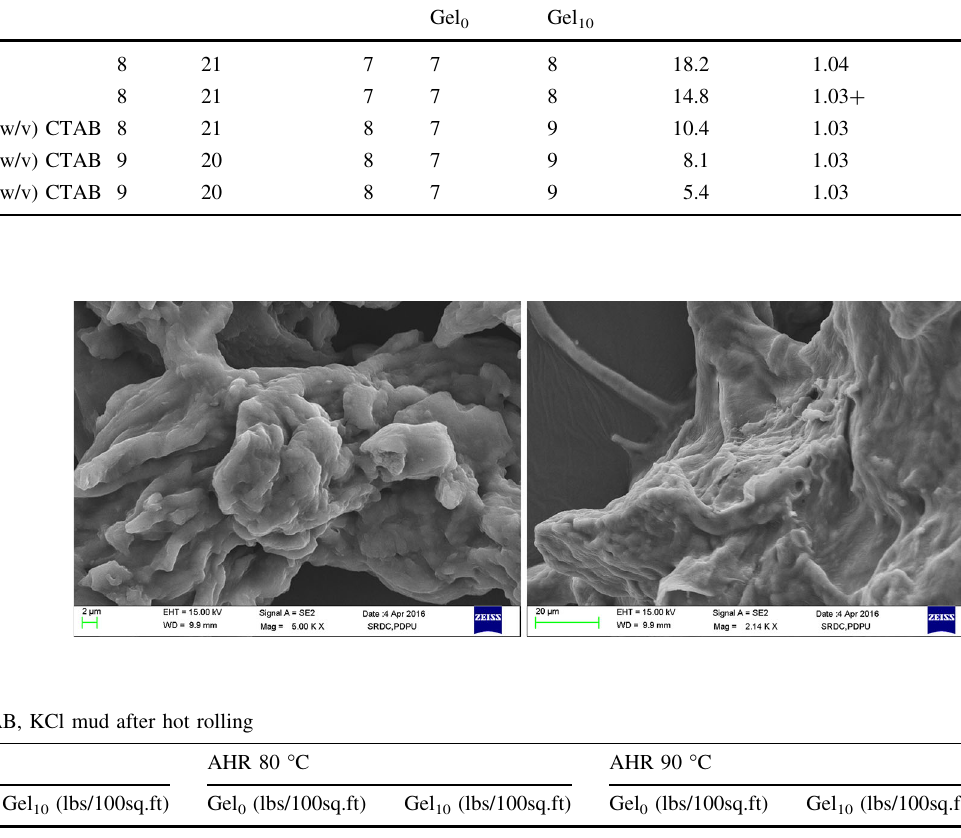
Table 7 Fluid loss controlling property of CTAB combination with PGS in K 2 SO 4 -inhibited mud DF Formulation